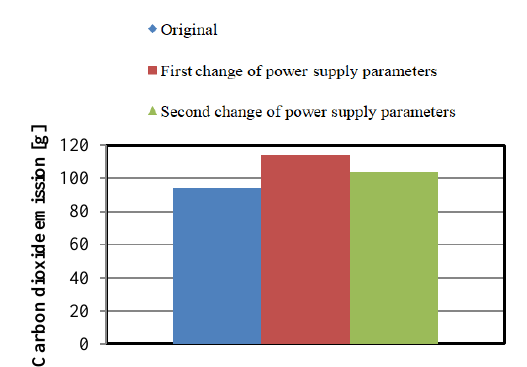
Fig. 12. Carbon dioxide emissions during the test in similar engine operating conditions